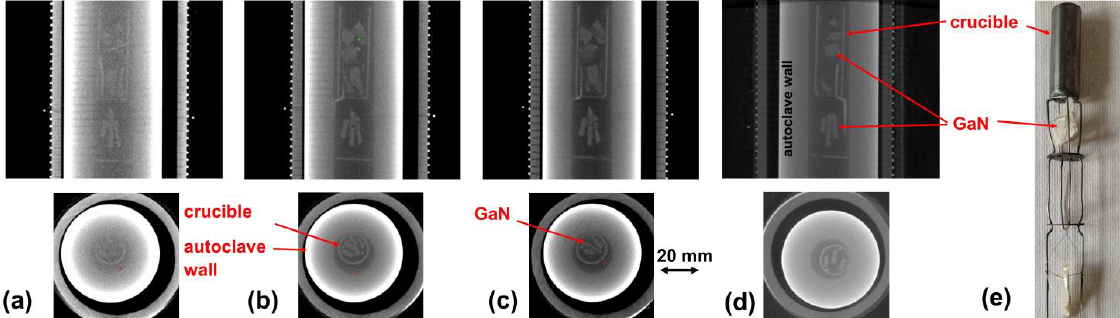
Figure 5. Computed tomography measurements obtained ex situ with an ammonothermal setup containing all typical elements except for the reaction medium. The material of the crucible was Inconel 718 in all cases. The material of the autoclave wall was Inconel 718 in (a), (b), and (c), whereas an autoclave made of Haynes 282 was used in ( d ). Different acceleration voltages were tested: ( a ) 300 kV; ( b ) 550 kV; ( c ) 600 kV; ( d ) 590 kV. The autoclave wall thickness was t = 14.5 mm in all cases. Subfigure ( e ) shows a photograph of the setup placed inside the autoclave, consisting of the Inconel 718 crucible, Inconel 718 wire standoffs, and GaN crystal pieces hung using a molybdenum wire. The effects of a silver liner and of the thinning of the autoclave wall can be seen from Figure 6. As expected, any significant reduction in the autoclave wall thickness leads to noticeable improvements in the overall transparency of the setup. Likewise, a silver liner of 1.5 mm (2.7 mm in the uppermost part of the left subfigure of Figure 6) leads to a safety environment of the operation. ographed thicknesses of both the autoclave wall and liner, as major absorbing compo-